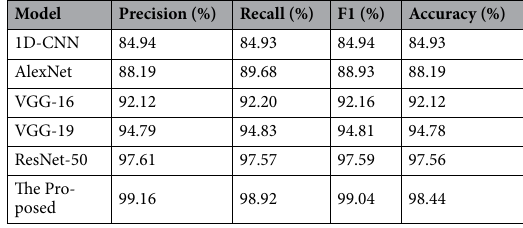
Table 5. The classification performance index matrix of the